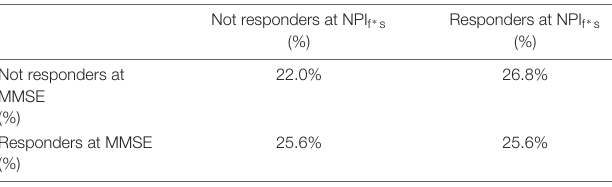
TABLE 2 | Percentages of responders and not responders to the treatment in cognitive and behavioral outcomes.